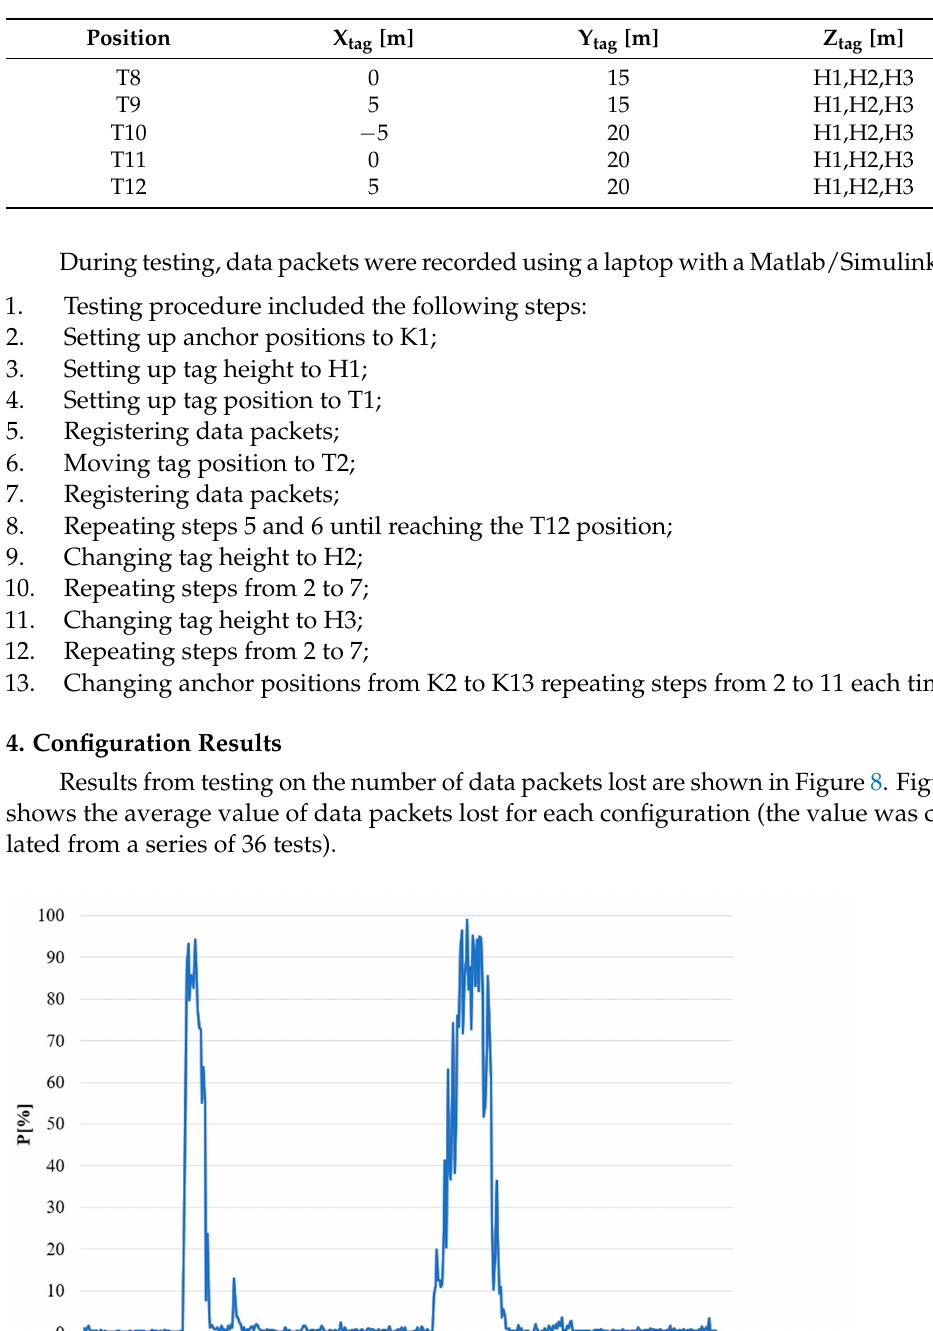
Figure 9. Average values of the number of data packets lost for each of the tested configurations. The average values of the number of data packets lost show that configurations no. 3, 8, and 9 (Figure 9) do not meet the set up requirement of 10% possible data packets lost, thus rendering them unusable for further testing and analysis. Removing these configu- rations allows for a more precise data analysis. Figures 10 and 11 show the same data types as Figures 8 and 9, but without said configurations.